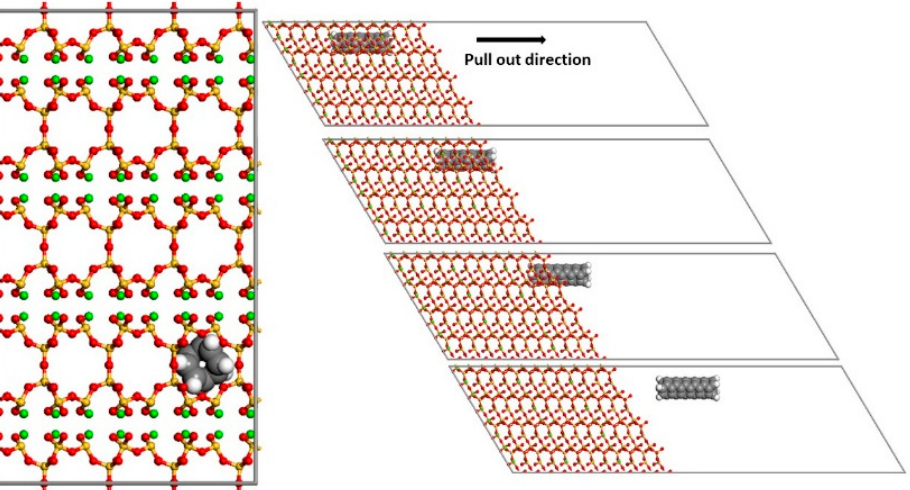
Figure 2. Side ( left ) and top ( right ) view of the models used for calculating ISS, showing an embedded pristine SWCNT (2,2) in a tobermorite matrix. The picture on the right depicts the pulling out process. Red: oxygen, Yellow: silicon, Green: calcium, White: hydrogen, Grey: carbon.